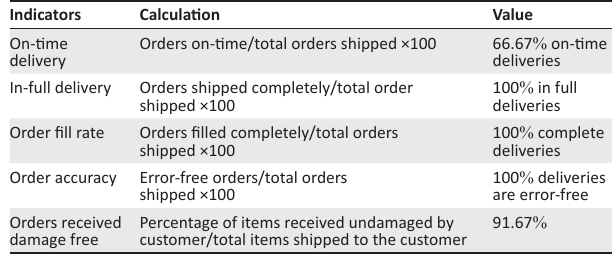
TABLE 5: Analysis of perfect order completion indicators.